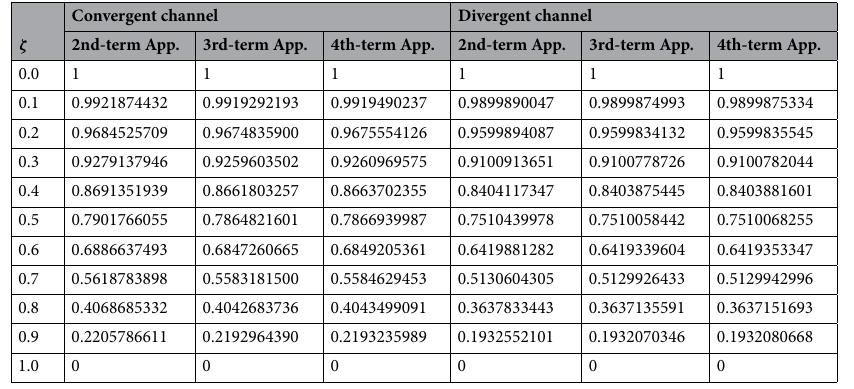
Table 5. Velocity profile of the nanofluid in uncertain case for converging and diverging channel when Re = 15, Ha = 500, α = 0.1, δ = 0.2, ω = ∓ 3 0 for Copper-H